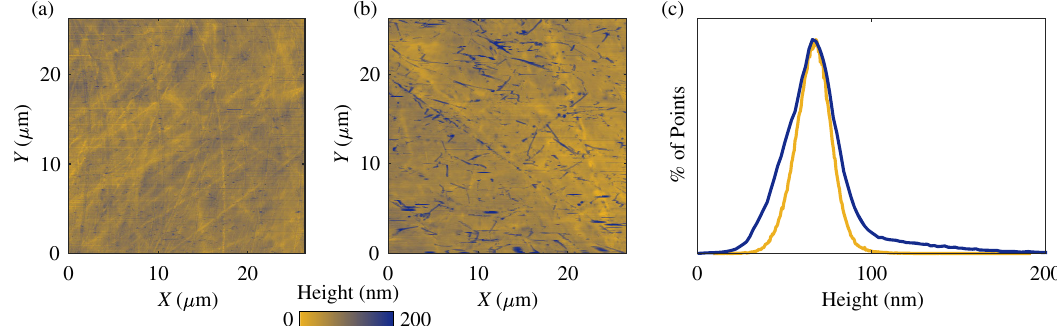
FIG. 7. AFM topographies and statistical analysis of surface roughness. Topography of clean (a) and nanowire-covered (b) Au surfaces. (c) Height distribution of the topography in (a) (orange) and (b) (purple). The roughness can be characterized by the variance of these distributions.